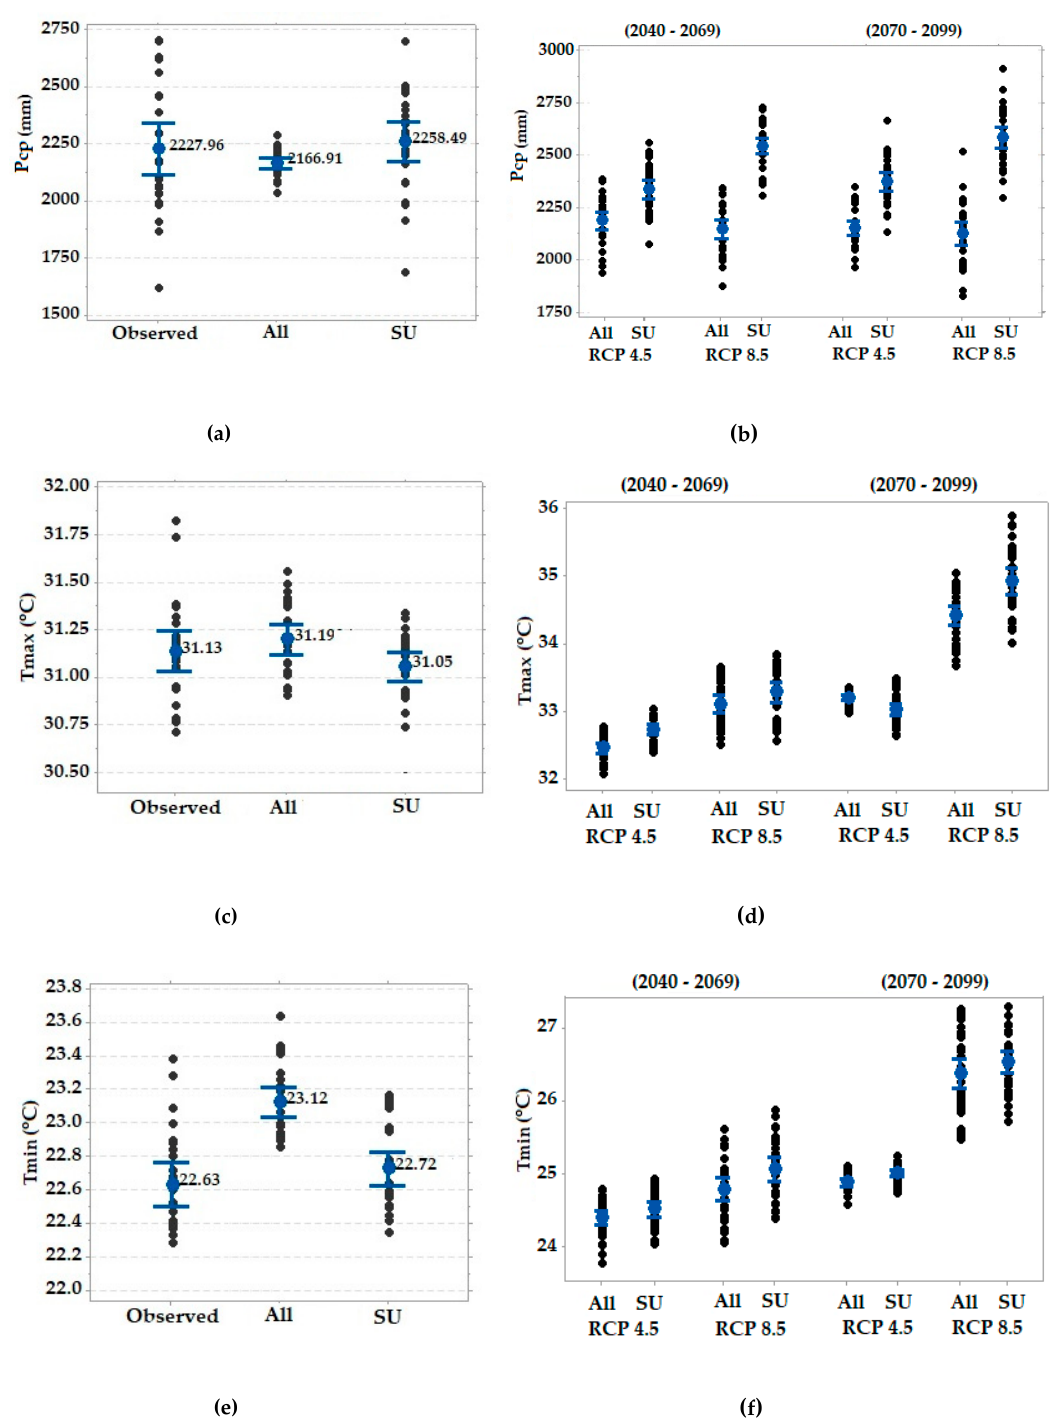
Figure 5. Interval plots for the annual averages of CRU datasets with the ensemble of all 26 GCMs and the four SU selected GCMs for ( a ) Prcp (base period), ( b ) Prcp (future periods), ( c ) Tmax (base period), ( d ) Tmax (future periods), ( e ) Tmin (base period), and ( f ) Tmin (future periods) with 95% confidence interval at the grid located in Port Harcourt.